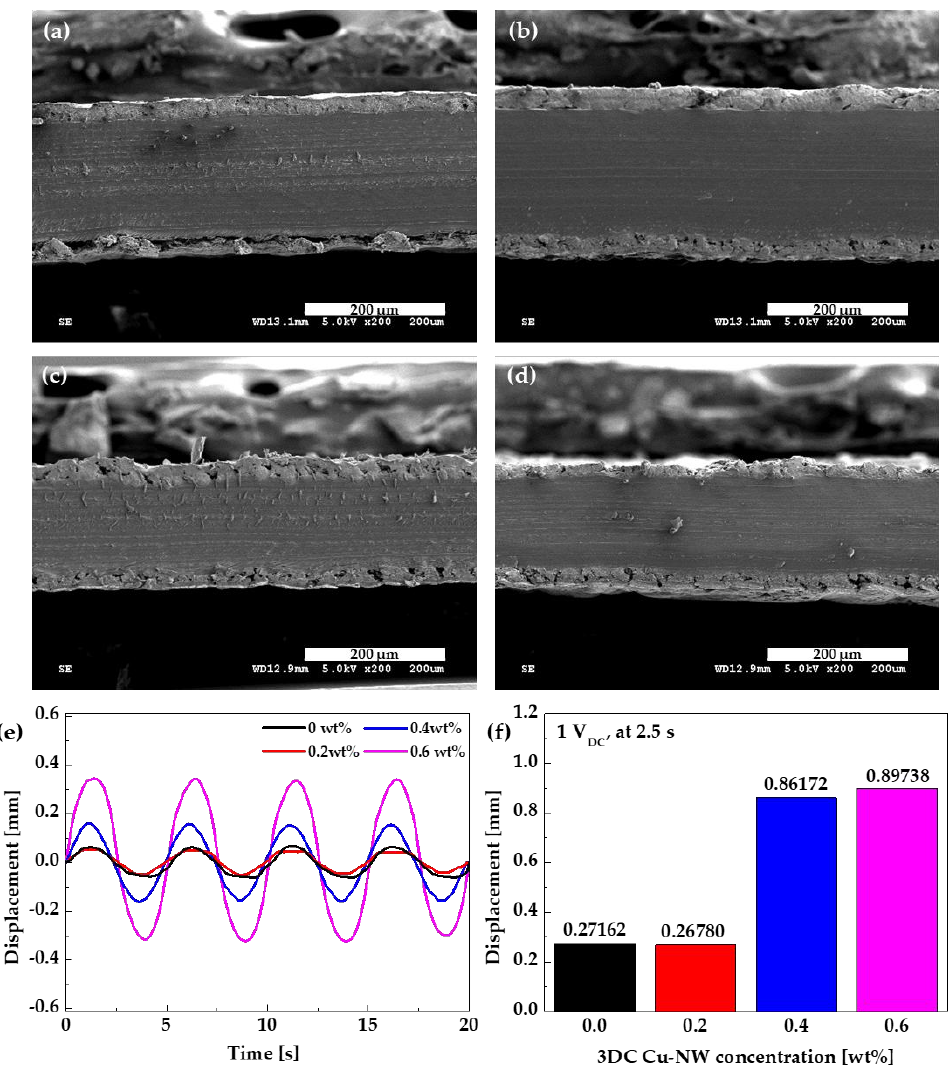
Figure 8. Cross sections of IPMC actuators with ( a ) 0, ( b ) 0.2, ( c ) 0.4, and ( d ) 0.6 wt% 3DC Cu-NW; ( e ) Displacement vs. time ( ± 1 V AC , 0.2 Hz), and ( f ) real-time displacement at 2.5 s under 1 V DC results for IPMC actuators according to 3DC Cu-NW concentration.